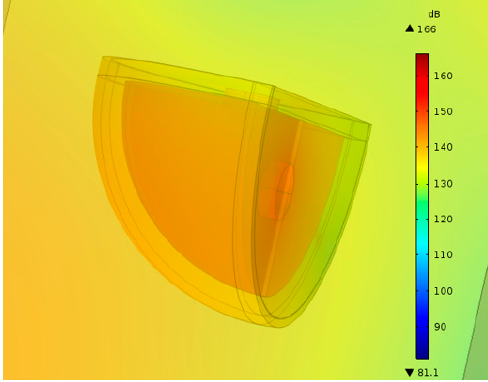
Figure 4. The simulation results of sound pressure level.